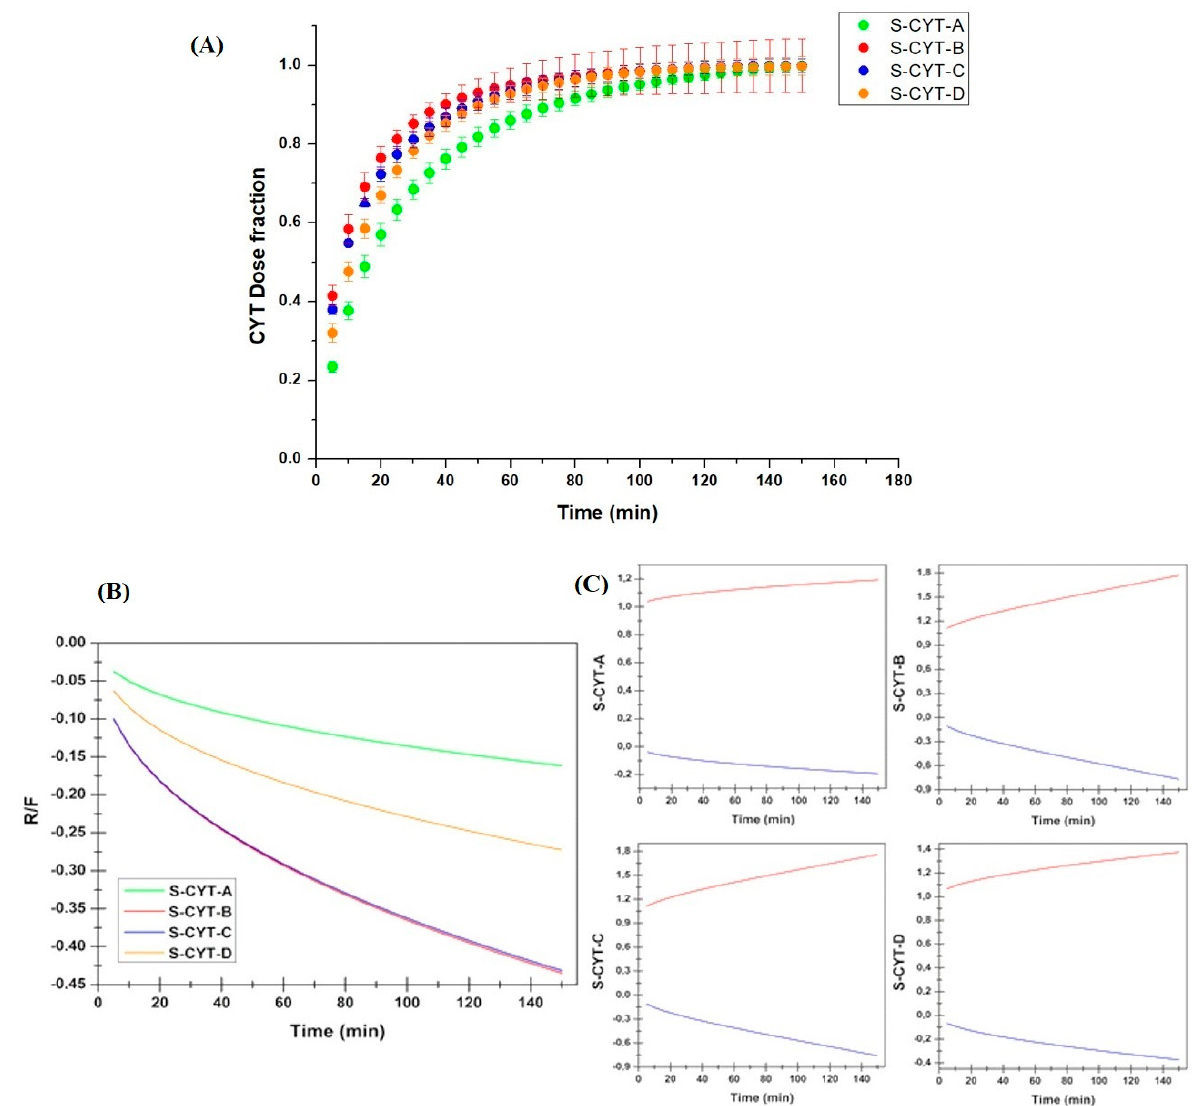
Figure 5. ( A ) Dose fraction of CYT released as a function of time (h) from S-CYT-A (green), S-CYT-B (red), S-CYT-C (blue) and S-CYT-D (orange) buccal tablets. Values are presented as means SE ± (n = 4) and evaluation of the Fickian diffusional contribution (F) and the Case II relaxation/erosional contribution (R) in the Peppas–Salhin model: ( B ) variation of the R/F ratio as a function of time; ( C ) detailed F (red) and R (blue) patterns for each formulation.